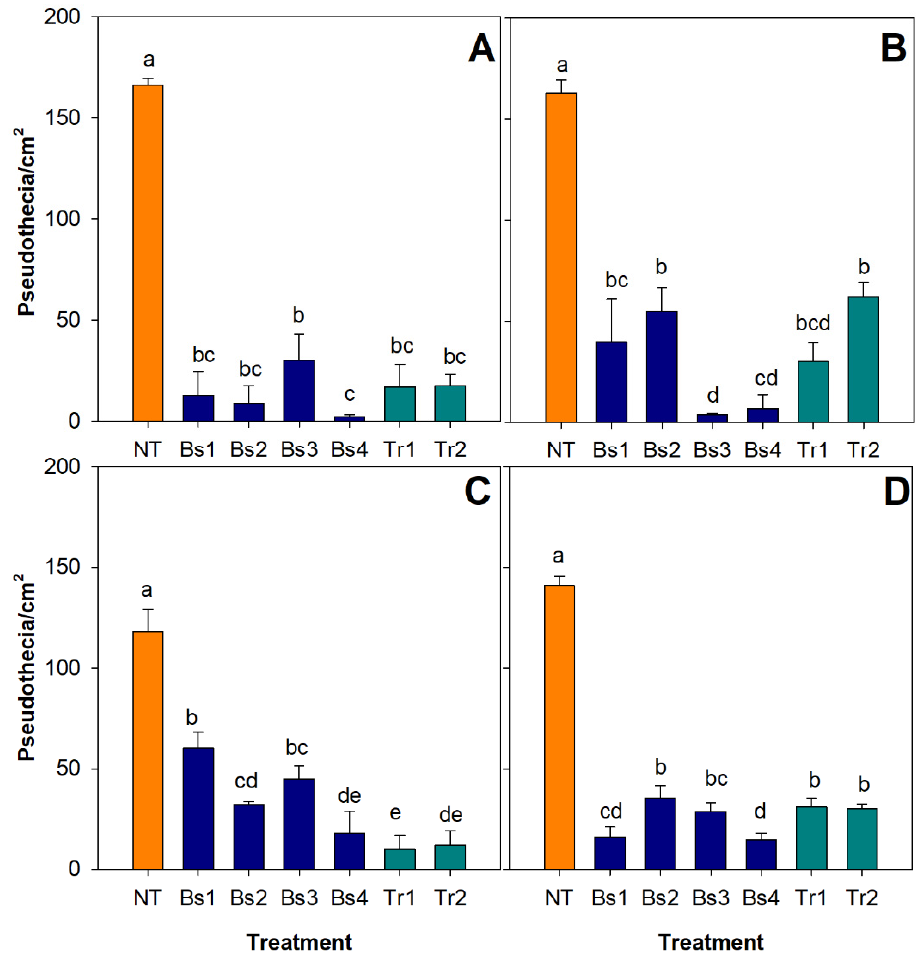
Figure 1. Effect of preventative applications of biological control agents (BCAs) in the pseudothecia of Pleospora allii production. BCAs used were Bacillus subtilis strains (Bs1, Bs2, Bs3, Bs4) or Trichoderma spp. strains (Tr1, Tr2). NT: non-treated control. Results are given as the mean and standard error of four experiments (( A ): experiment 1; ( B ): experiment 2; ( C ): experiment 3, and ( D ): experiment 4). Bars with the same letter are not significantly different according to Fisher’s protected least significant test ( p < 0.01).